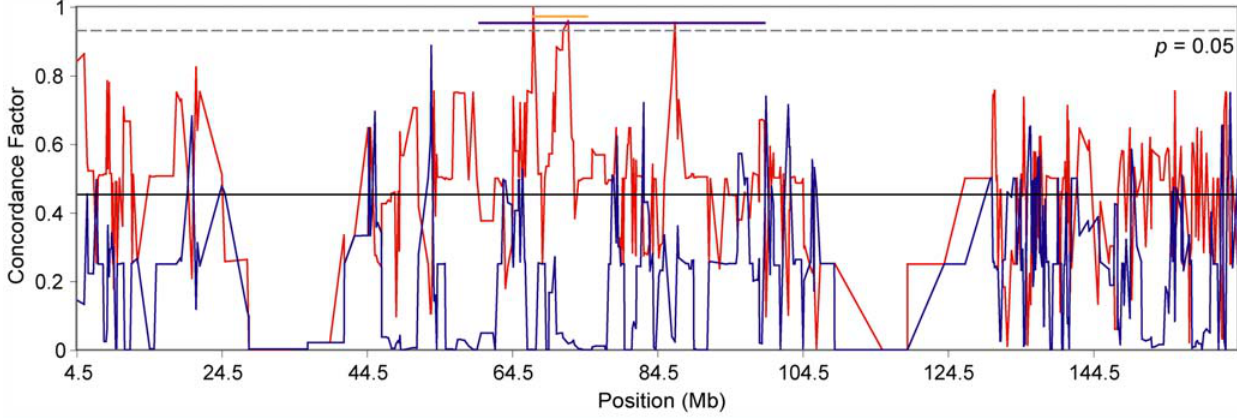
Figure 6. Sliding window analysis of discordance across the X chromosome. Discordance within a four-locus sliding window was calculated across the X chromosome and is plotted as the midpoint position of each window. The M. m. musculus / M. m. castaneus topology (red) shows significantly higher regions along the X chromosome where known hybrid male sterility loci are mapped ( Hstx1 ) [46]. The M. m. musculus/M. m. domesticus topology (blue) decreases within these regions. The entire Hstx1 interval is indicated by the purple line, whereas the peak of this quantitative trait locus is indicated by the orange line. The black line indicates the chromosome-wide concordance factor for the M. m. musculus/M. m. castaneus topology (0.450).